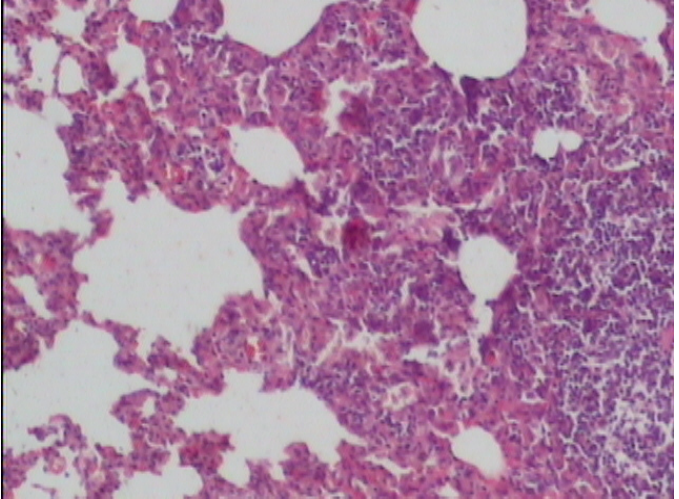
Figure 3. Prebiotic